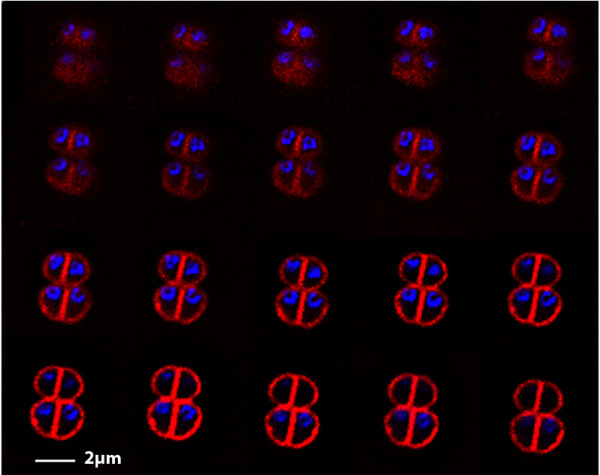
Optical sections of a tetrad of D. radiodurans R1. The series is in order from left to right of images within a row and from top to bottom of rows within the figure. Images are taken at 100 nm intervals. The DNA (blue) is stained with DAPI and the lipid membrane (red) is stained with FM-4-64.